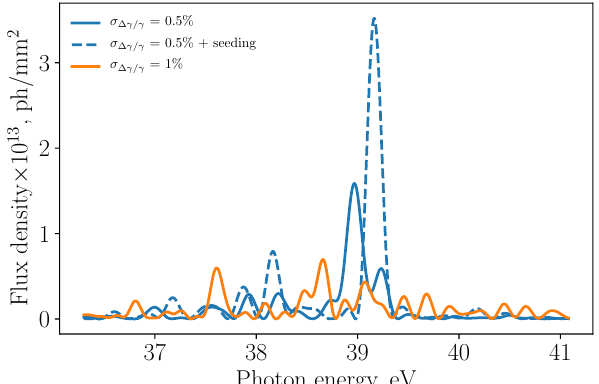
Figure 6. Flux density in units of number of photons/pulse/mm 2 per the energy bandwidth of 0.1% without (solid line) and with external seeding (dashed